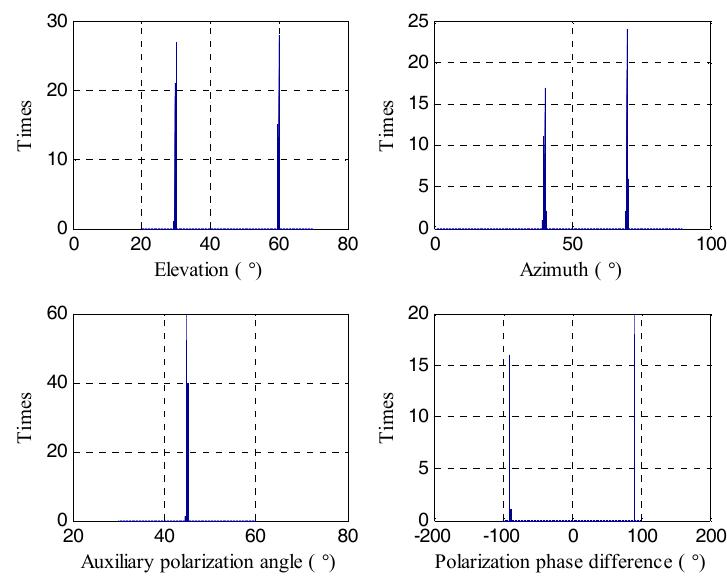
Figure 4. The estimation result of the proposed C-SPD ESPRIT-like algorithm.